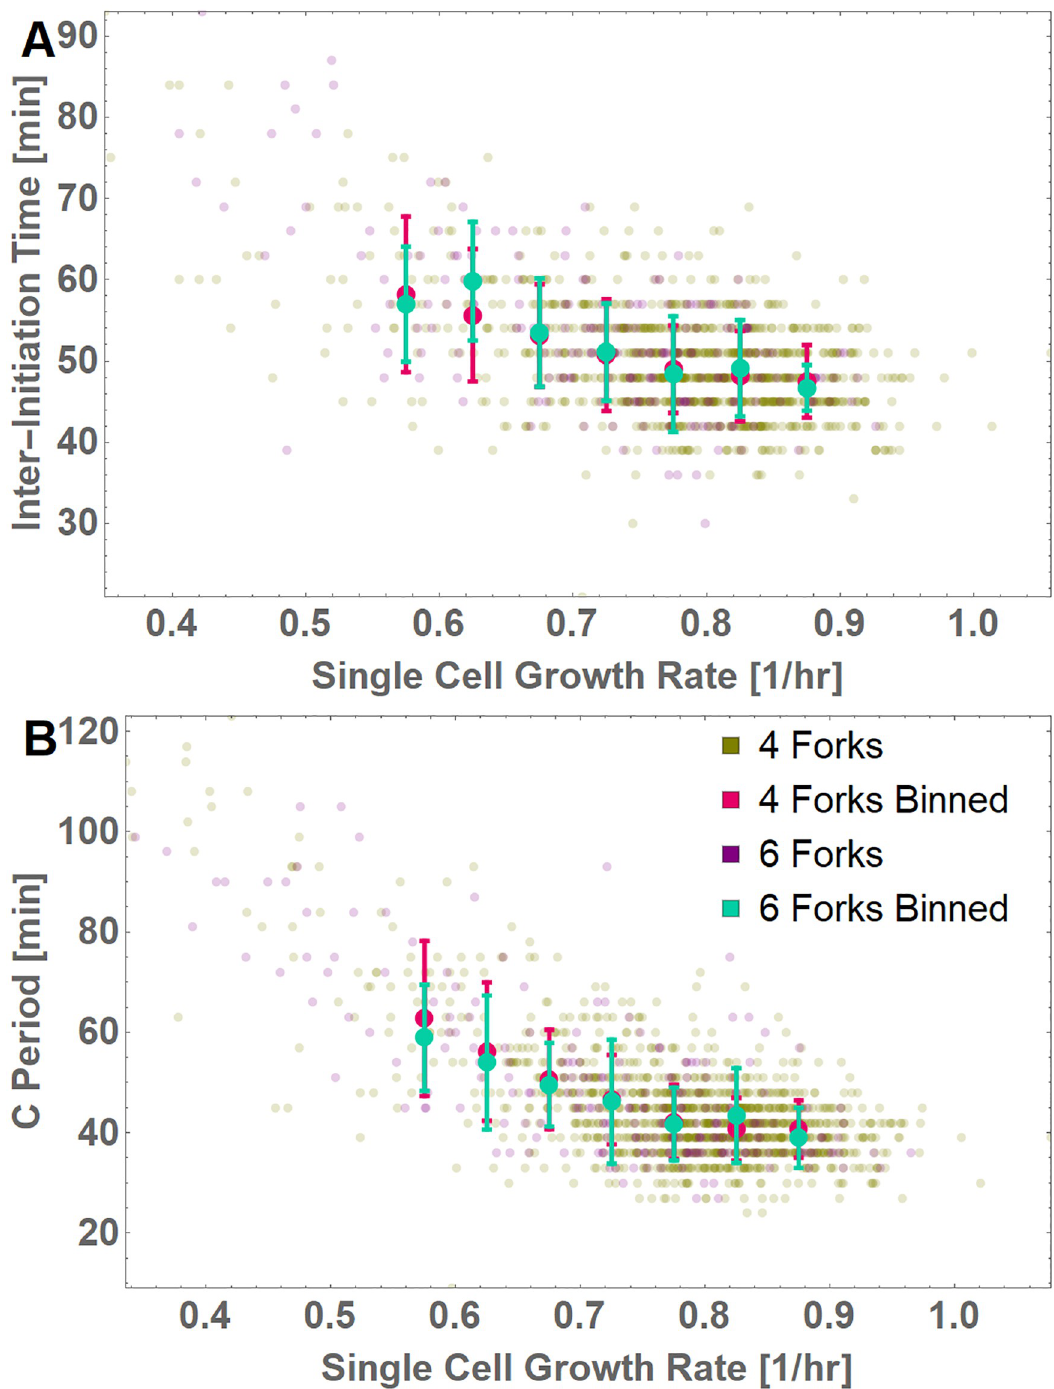
Fig 8. Both inter-initiation time and C period are independent of fork number. (A) Inter-initiation time ( τ ( τ C ) is plotted against single-cell growth rate ( k ) for an intermediate growth condition (medium 4). Mean and SD of binned C periods and the spread of data points are plotted separately for ● 4-fork (single fork) and ● 6-fork (multifork) data, based on the fork number observed just after